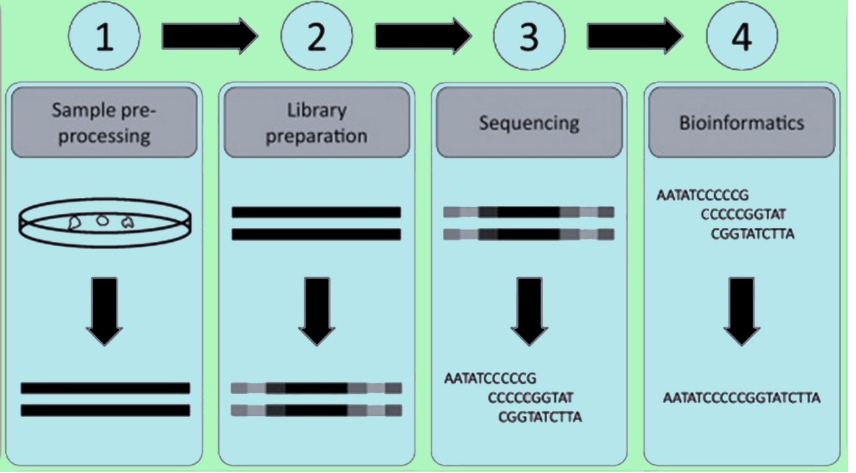
Figure 2. Next-generation sequencing workflow steps [5,9,17,18].